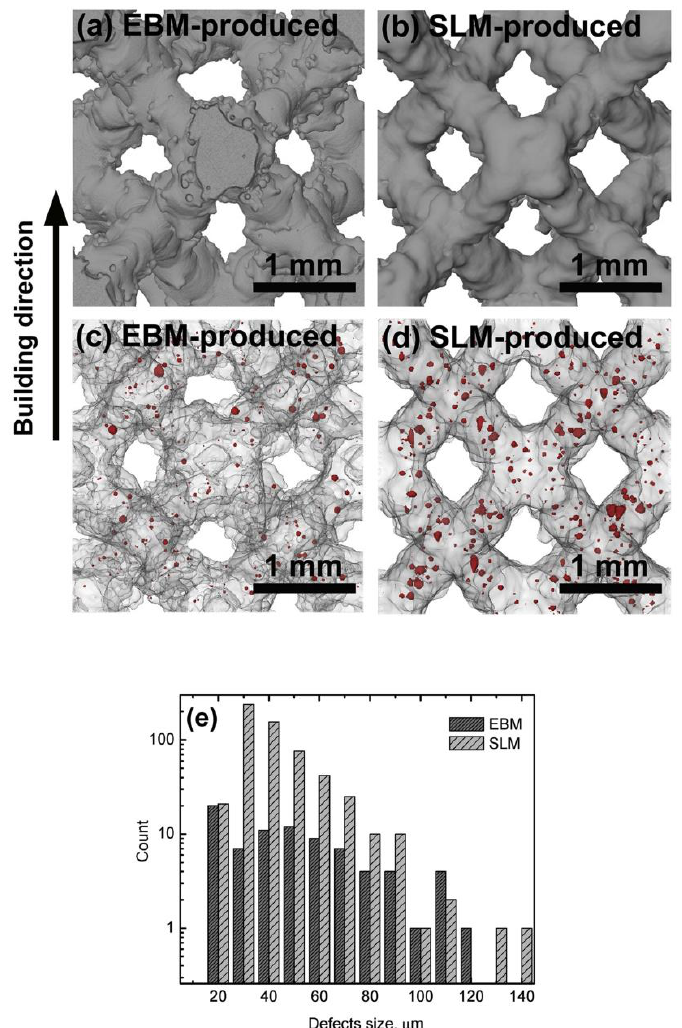
Figure 18. The micro-CT reconstructed images showing the strut outside surface of the ( a ) EBM and ( b ) SLM samples, the defects inside of the solid struts of the ( c ) EBM and ( d ) SLM samples, and ( e ) the size and count distribution of the defects inside the samples as a function of equivalent diameter [177]. (Reprinted with permission from Acta Materialia, vol. 113, Liu et al., Microstructure, defects